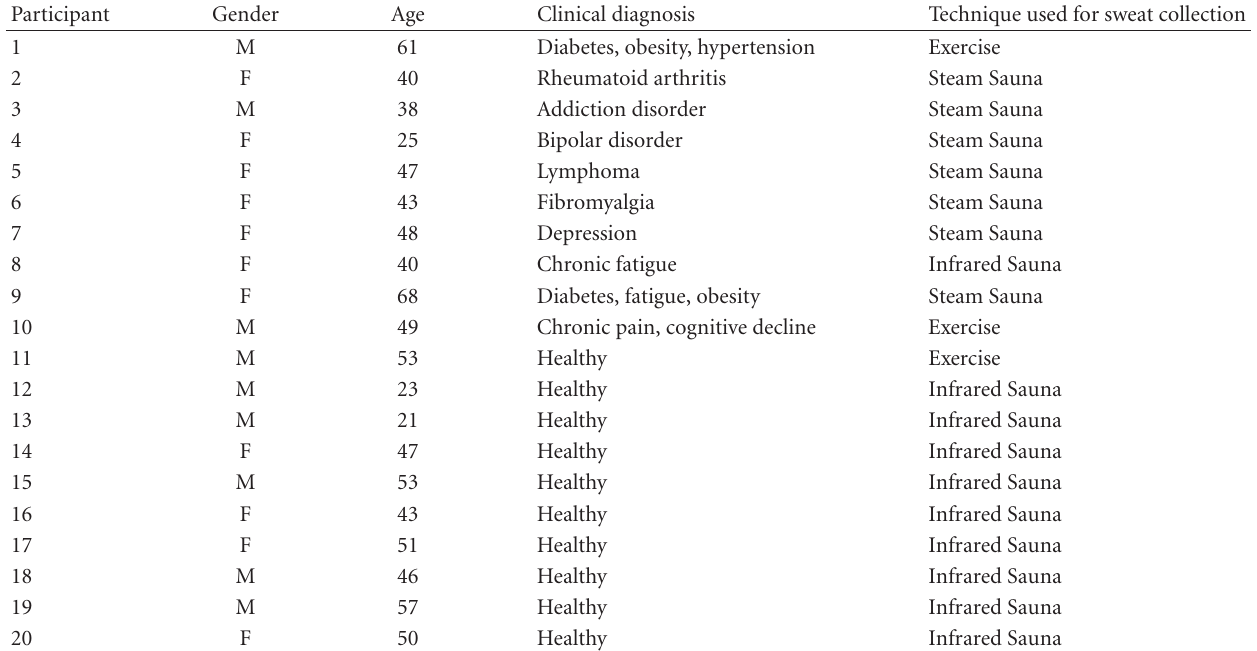
Table 1: Participant demographics and general clinical characteristics.